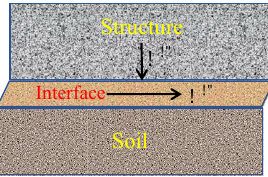
Figure 1. Irreversible displacements of the soil–structure interface.